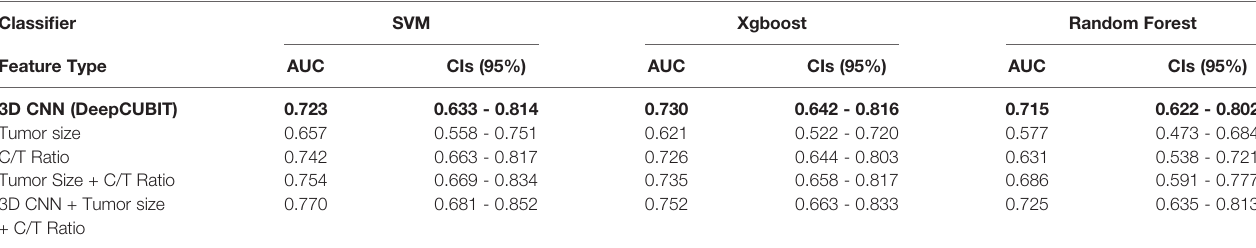
TABLE 3 | Performance evaluation for test data (Cohort I, average of 5 fold hold-out test set).